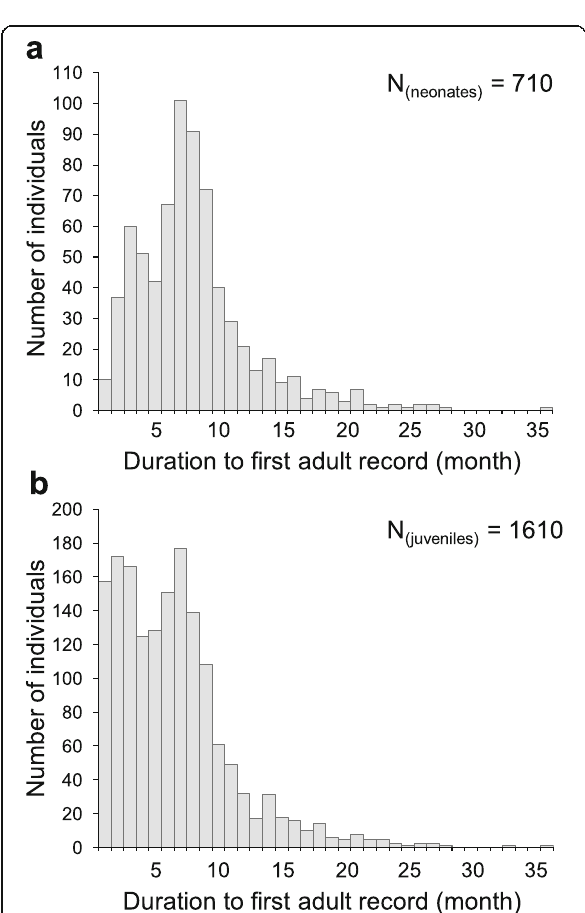
Fig. 5 Fast growth and maturity of Takydromus viridipunctatus demonstrated by recapture records. a Among the 1610 individuals which were first captured as juveniles, over 91% of them (1465) reached sex maturity within one year. b Among a total of 710 newly hatched neonates (SVL smaller than 32.97 mm) which survived to adults, over 87% of them reached maturity within one year. Since the duration of two (or more) capture events relies on the premise that an individual should be successfully recaptured, the maturity speed could be under- estimated (faster, but not slower) in this